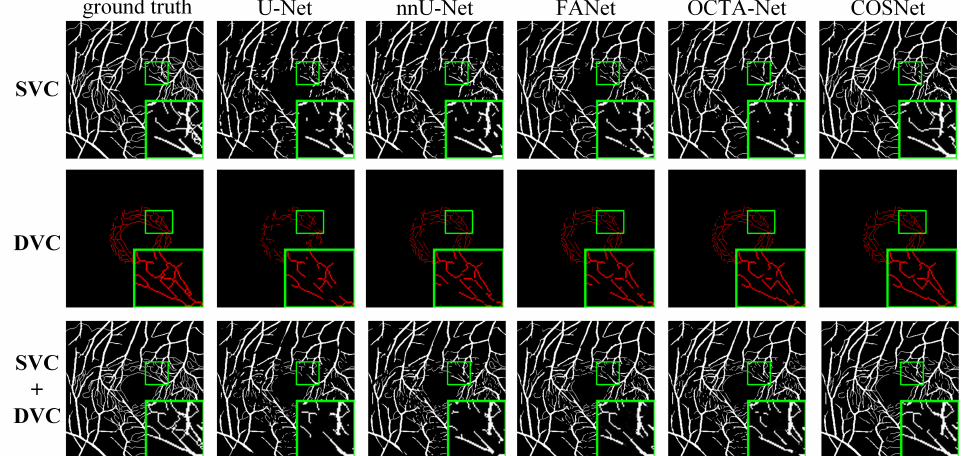
Figure 7. Segmentation results for